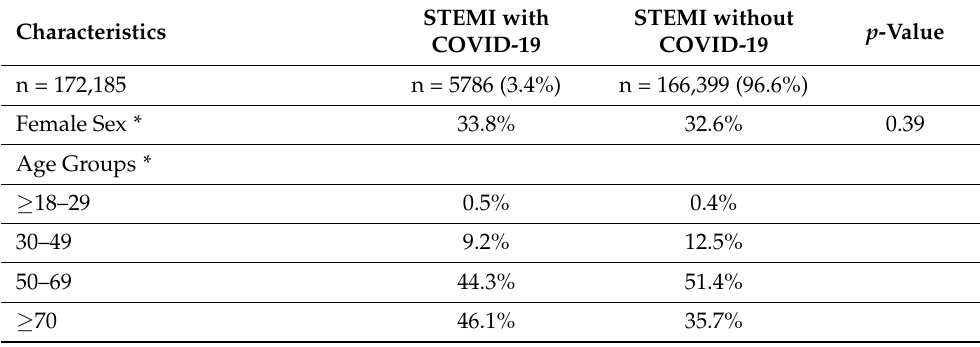
Table 1. Baseline characteristics of STEMI patients, based on COVID-19 status.